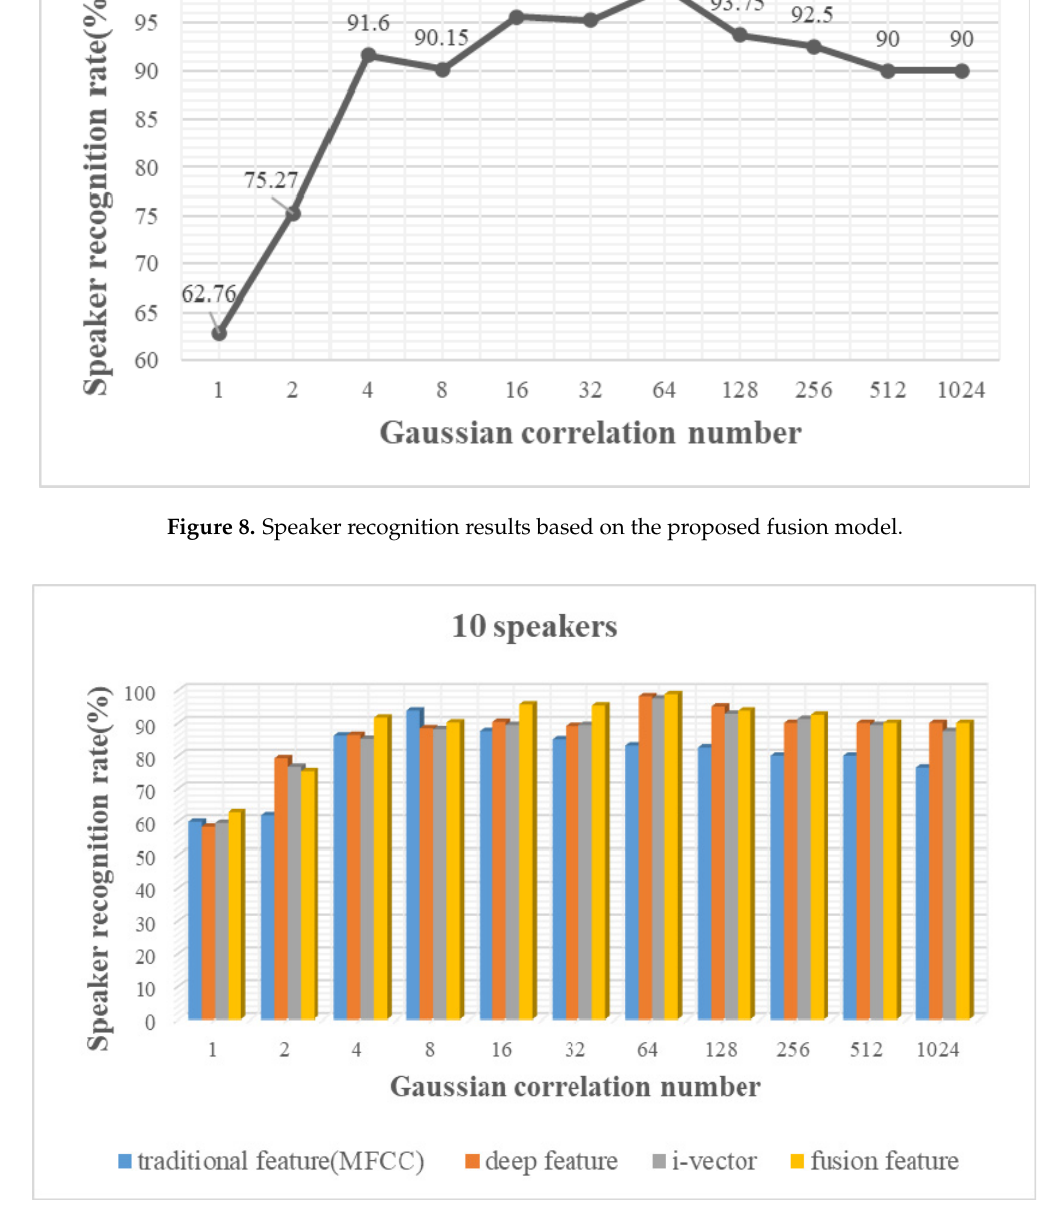
Figure 9. Speaker recognition rate based on four types of features (10 speakers).